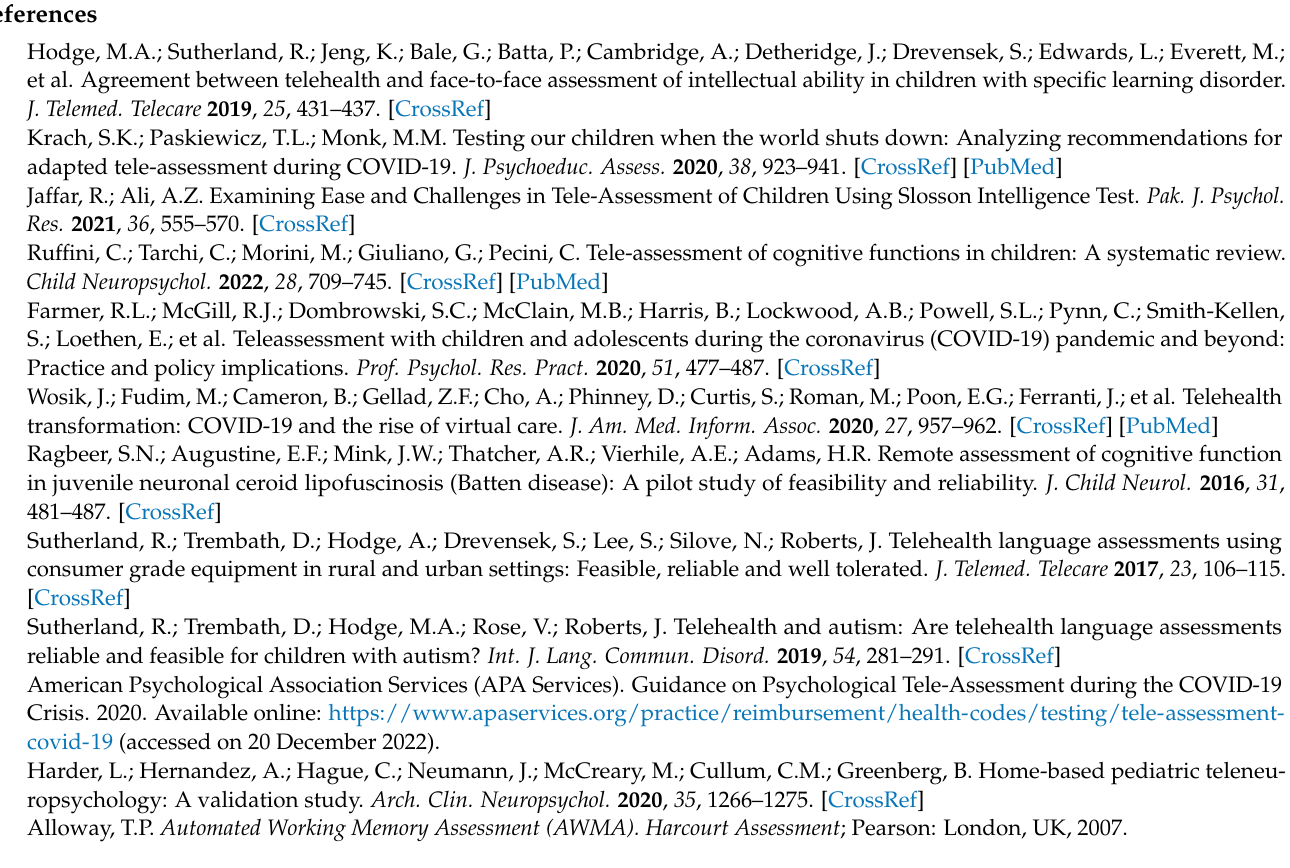
Table S1: estimated marginal means of accuracy condition (congruent–incongruent) * class* AM for blocks 1 and 2 in the flanker task, and Table S2: estimated marginal means of accuracy condition (congruent–incongruent) * class* AM for block 3 in flanker